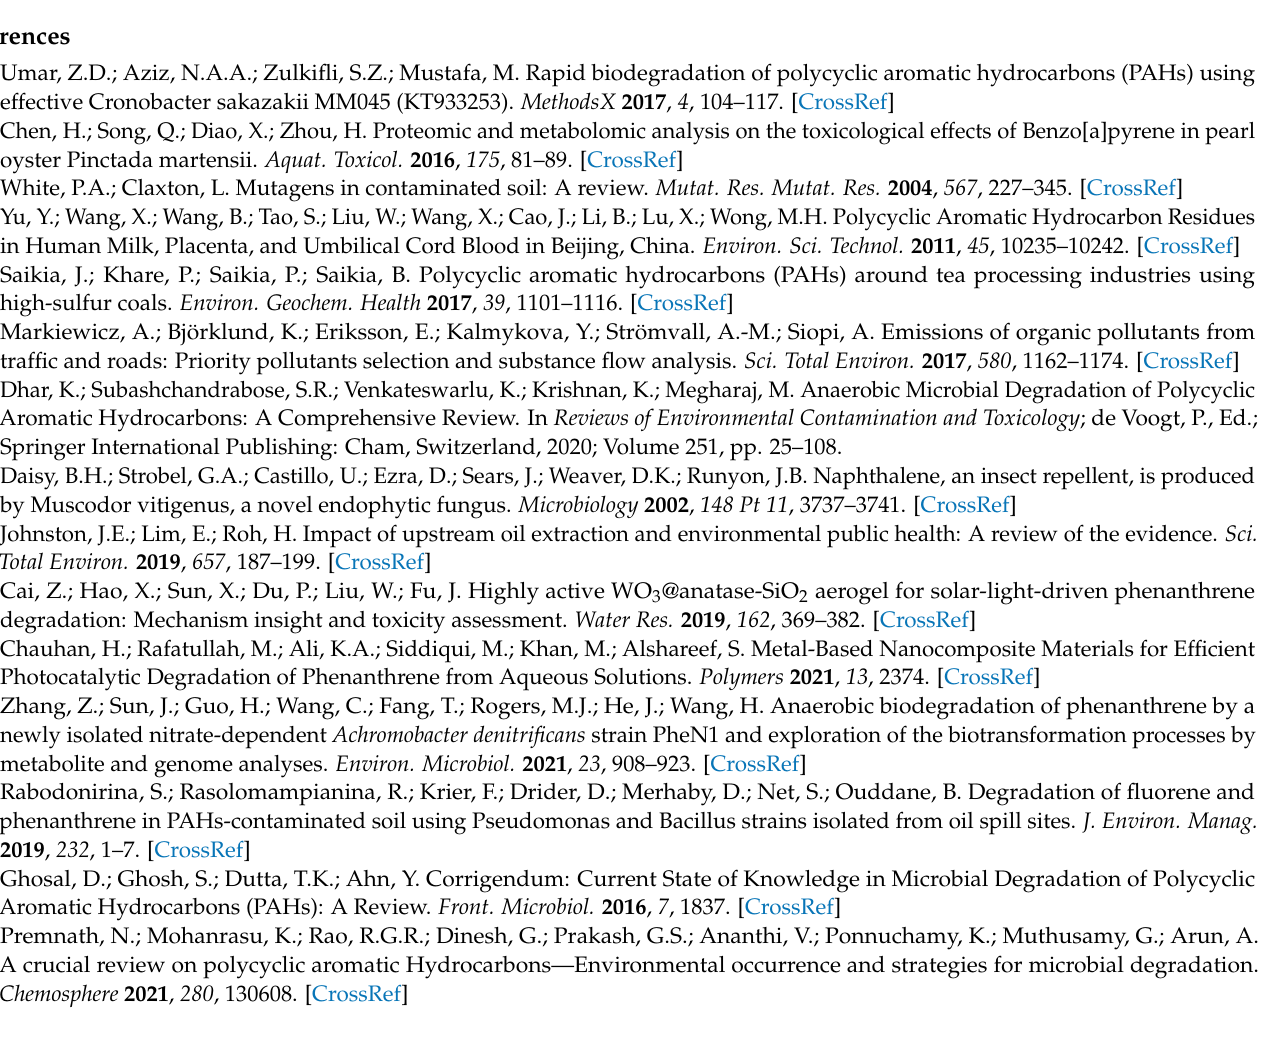
Figure S4: The pathway of Metabolism of xenobiotics by cytochrome P450; Table S1: Ingredients of Minimal Salt Medium; Table S2: Alpha Diversity index for six simples at 97% consistency threshold; Table S3: Functional category of the abbreviation in Figure